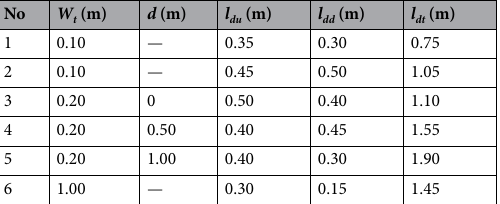
Bed form characteristics. Figure 4a shows the pictures of the final morphology of a river bed protected by different TFPW. Obviously, under the protection of TFPW, an armoring layer existed on the surface of the river bed near the banks after scouring. Whereas in the central channel, a certain range of sediment deposition existed not only upstream of the TFPW but also downstream from them. Interestingly, the particle size of the depositing layers and the dune heights were various from upstream to downstream. It was observed that the dune heights upstream of the TFPW were slightly higher than those downstream of the TFPW and the particle sizes both upstream and downstream of the TFPW were finer than the sediment of the riverbed before scouring. Further, the sediment size of the TFPW downstream deposition was much finer than upstream of the TFPW. For the TFPW with different layout types, the range of deposition was not the same. In Test 1, although the refinement of the deposition layer was not obvious around the TFPW, it could be observed that the sediments upstream of the Single TFPW were coarser than those downstream of the TFPW. However, the finer particles downstream of the TFPW did not deposit at the heel of the TFPW but were located at a distance of 0.3 ~ 0.4 m from the heel of the TFPW. The Single TFPW in Test 2 had a better effect on promoting sediment deposition than that in Test 1, where the phenomenon of deposition layer refinement both upstream and downstream of the TFPW was more obvious. The finer deposition layer extended from the heel of the TFPW to a certain distance of